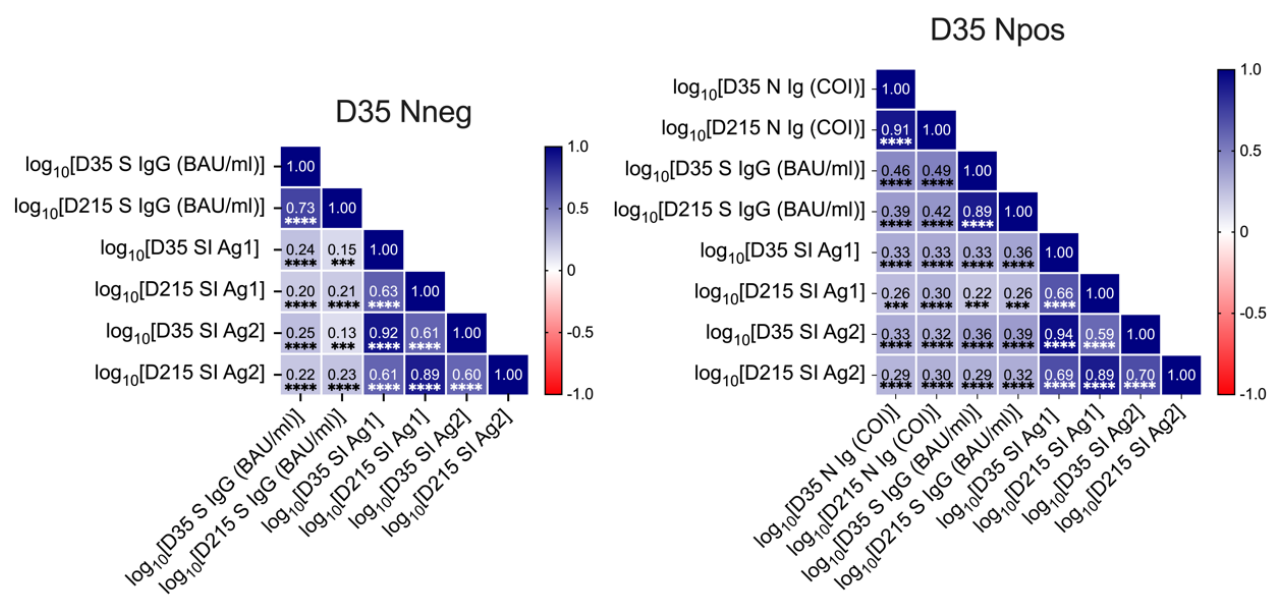
Figure 4. Correlation of different immune parameters measured at D35 and D215 in the D35 Nneg and Npos groups. Pearson correlation coefficients were calculated to assess the correlation between log10-transformed values of immunological parameters measured at study baseline and at follow-up. p values ≤ 0.001 and < 0.0001 are represented with *** and ****, respectively.